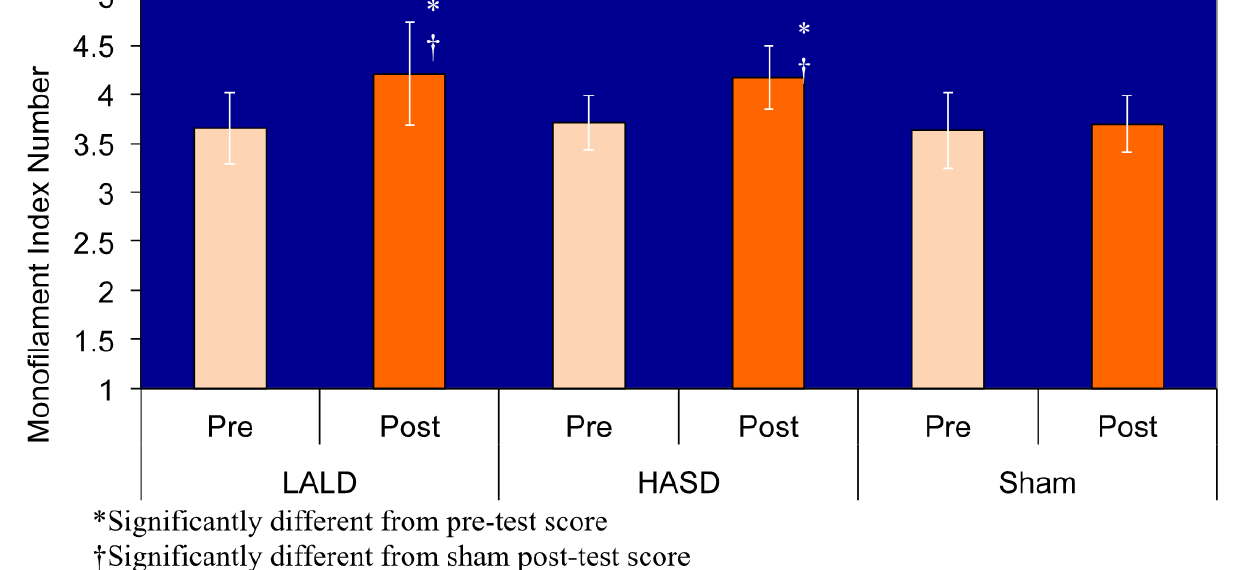
Figure 1. Means of Semmes Weinstein monofilament scores by condition and